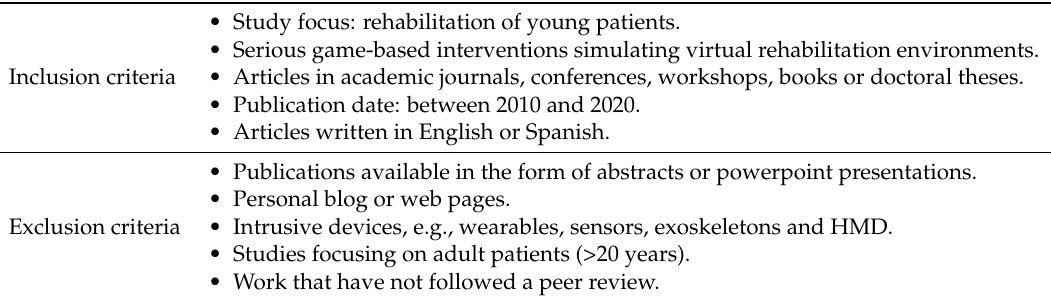
Table 3. Study selection (inclusion and exclusion criteria).